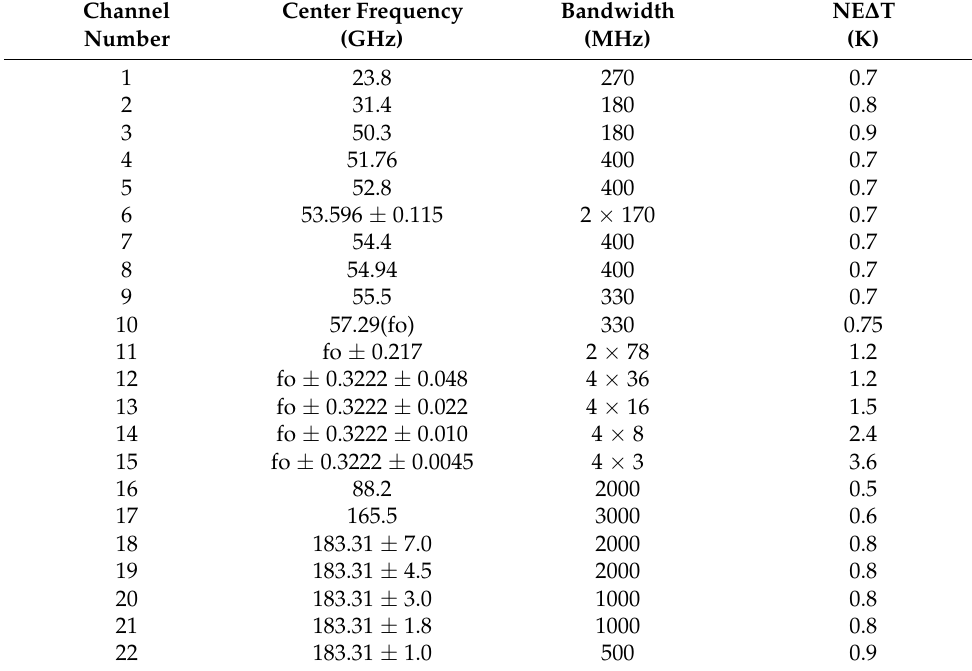
Table 1. ATMS instrument